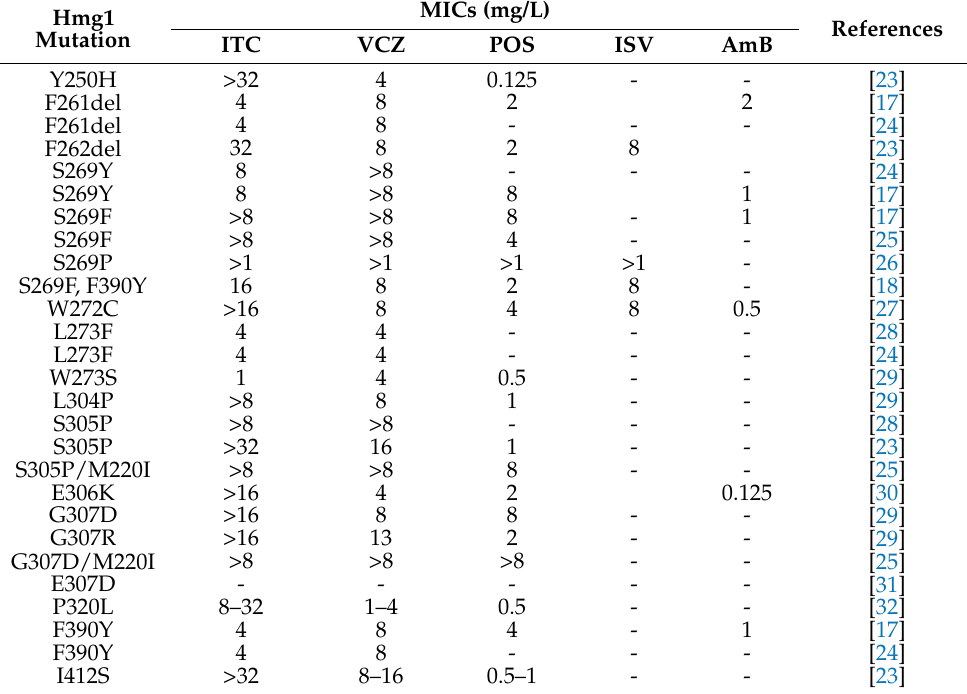
Table 1. Mutations in the SSD domain of Hmg1 that have been reported to be involved in A. fumigatus azole resistance and MICs to azoles and AmB of the